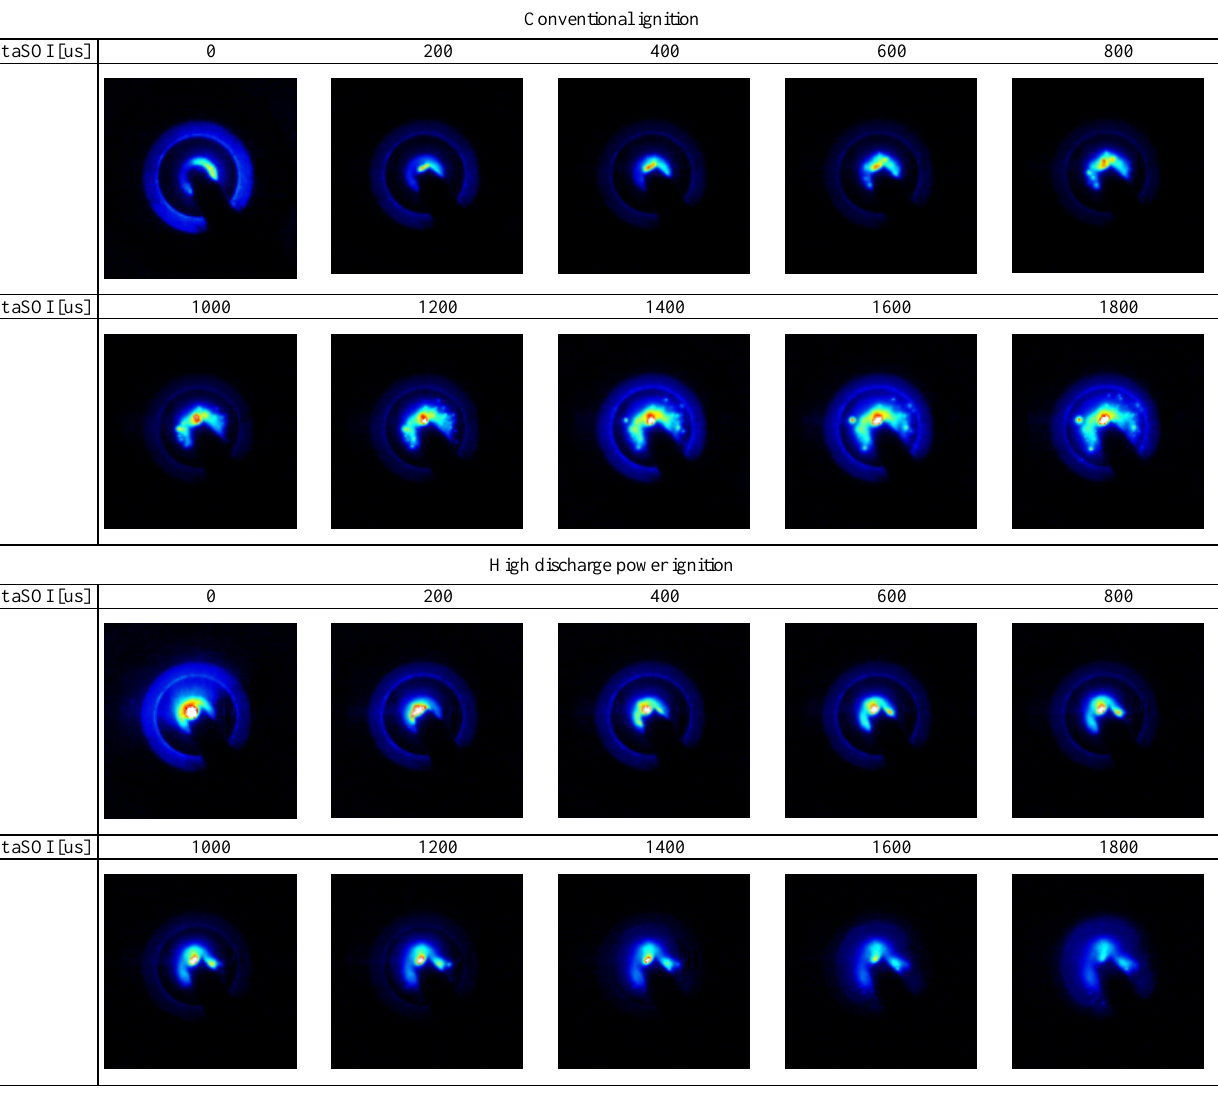
Fig. 5. Images of the ignition phase start (f = 5 kHz, the first image represents SOI – start of